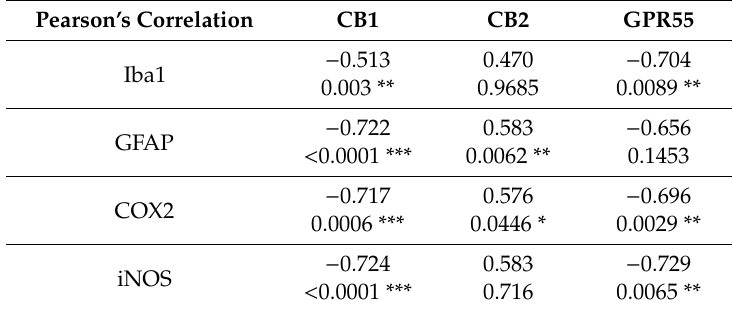
Table 2. Pearson’s correlation between endocannabinoid receptors (CB1, CB2, and GPR55) and neuroinflammation-related proteins measured by Western blot analysis in 5xFAD transgenic mice